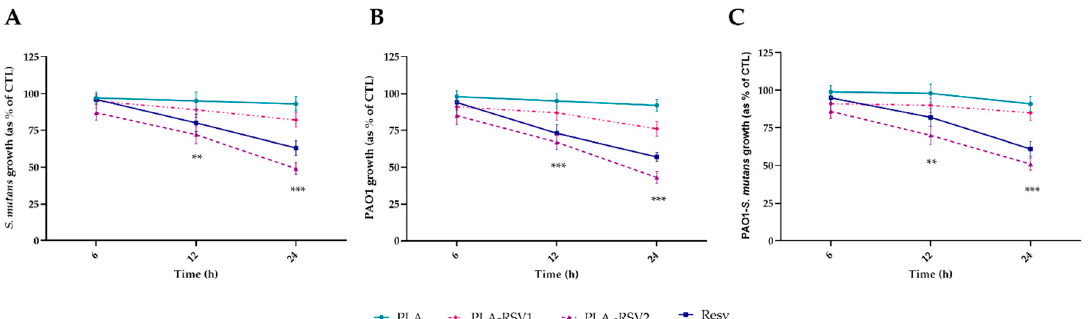
Figure 7. Antibacterial activity evaluated at 600 nm against Streptococcus mutans (A) , Pseudomonas aeruginosa PAO1 (B), and PAO1- S. mutans (C) of PLA, PLA-RSV1, and PLA-RSV2. Bacterial growth in absence of membranes was used as bacterial positive control (CTL) while 200 μ M resveratrol was used as positive standard control (RSV). Data were reported as a percentage in comparison with a bacterial positive control. For each sample, six different experiments were conducted and the results expressed as the mean of the values obtained (mean ± SD). Statistically significant variations: ** p < 0.01, and *** p < 0.001 versus PLA and PLA-RSV1.